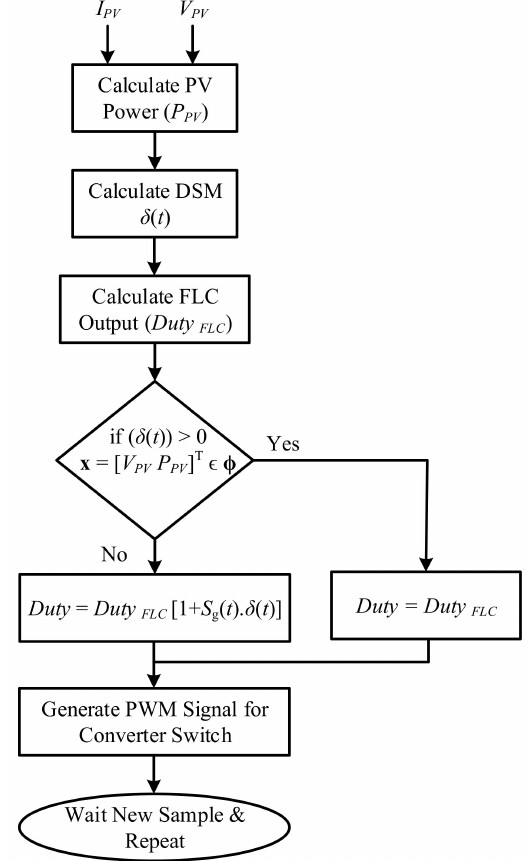
Figure 8. Flow chart of the proposed DSM based FLC